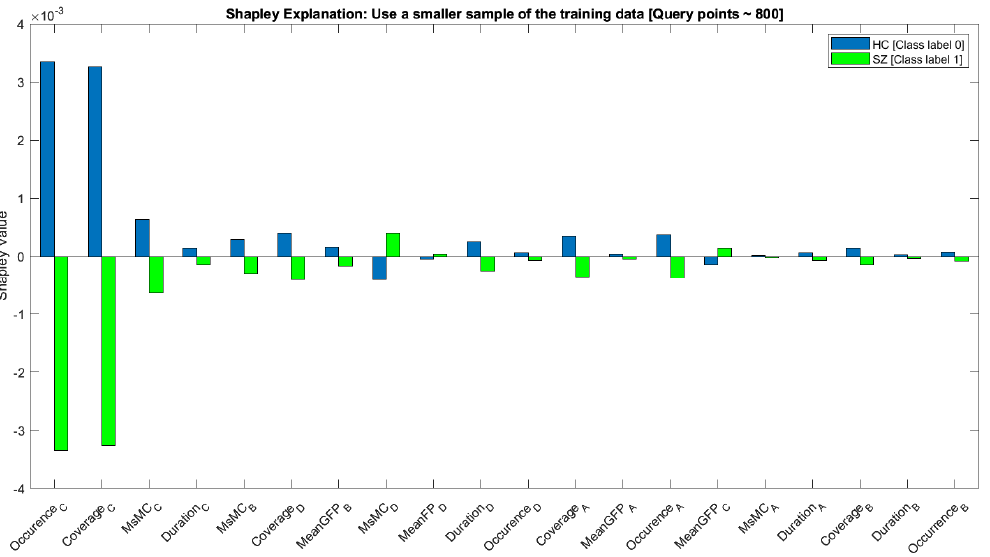
Figure 4. Shapley additive explanation values for the microstate features to explain the contribution of individual features to the prediction.